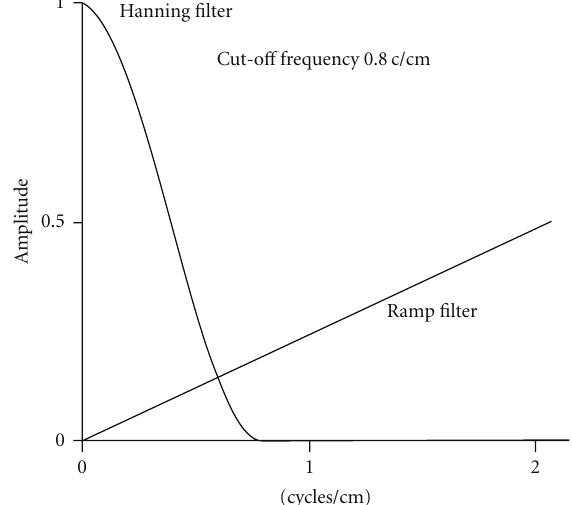
Figure 5: Hanning filter and Ramp in FBP reconstruction.